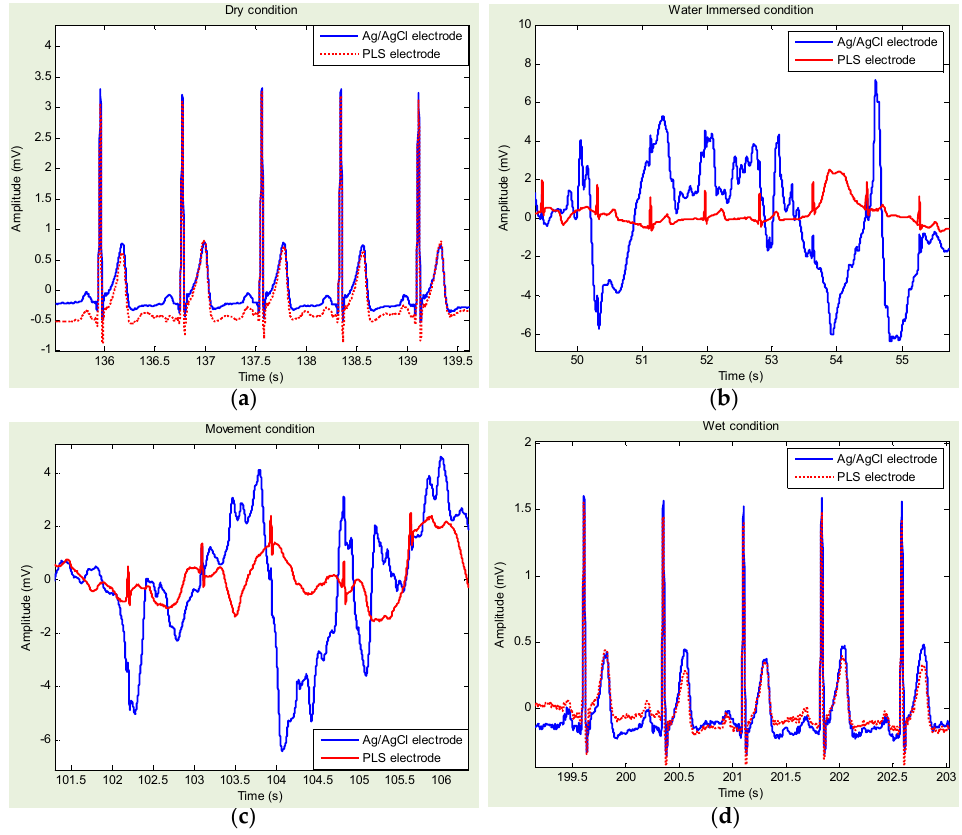
Figure 6. (Experiment I—Pencil lead solid-type (PLS) electrode compared with Ag/AgCl electrode) Example of electrocardiogram (ECG) signals for each experimental condition: ( a ) dry condition; freshwater immersed condition: ( b ) without movement; and ( c ) with movement; and ( d ) freshwater wet condition. ECG signals acquired with Ag/AgCl (blue line) and PLS electrodes (red line).